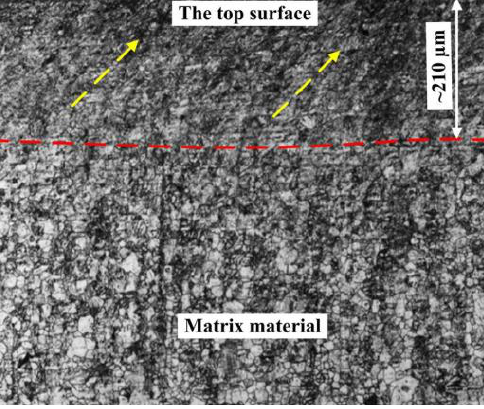
Figure 3. The cross-sectional microstructure of the HFIR specimen.